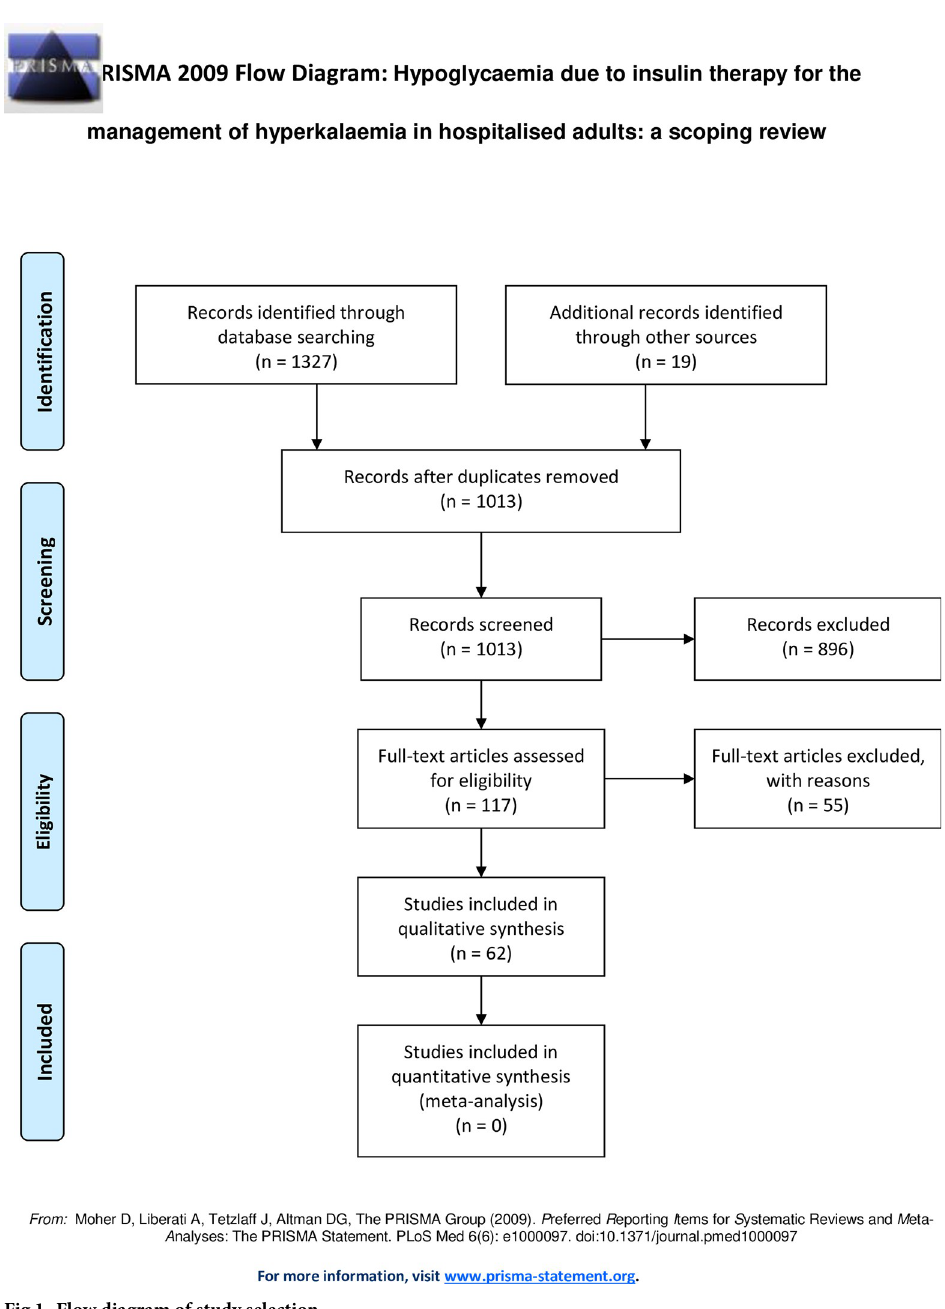
Fig 1. Flow diagram of study